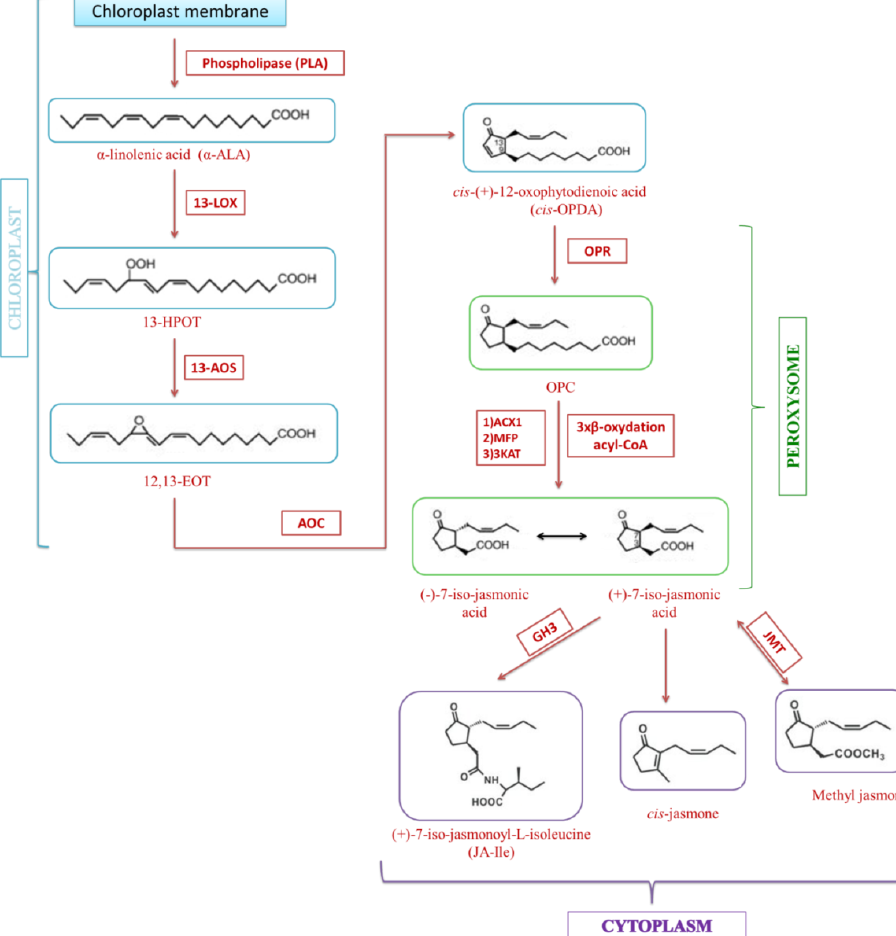
Figure 3. Synthesis of jasmonate compound. Abbreviations for compounds: α-ALA, α-linolenic acid; 13-LOX, 13-lipoxygenase; 13-HPOT,(13S)-hydroperoxyoctadecatrienoic acid; 13-AOS, allene oxide synthase; 12,13-EOT, 12,13-epoxyoctadeca-9,11,15-trienoic acid; AOC, allene oxide cyclase; JMT, jasmonate methyl transferase; GH3, Grechten Hagen 3; OPDA, cis-(+)-12-oxophytodienoic acid; OPR3, 12-oxo-phytodienic acid reductase3; OPC-8, 3-oxo-2-(2-pentenyl)-cyclopentane-1-octanoic acid; ACX1, acyl-CoA oxidase1; MFP, the multifunctional proteins; 3KAT, L-3-ketoacyl-CoA-thiolase; (3R,7R)(-)-JA, (3R,7R)(-) stereoisomer of jasmonic acid; (3R,7S)(+)-JA, (3R,7S)(+) stereoisomer of jasmonic acid.